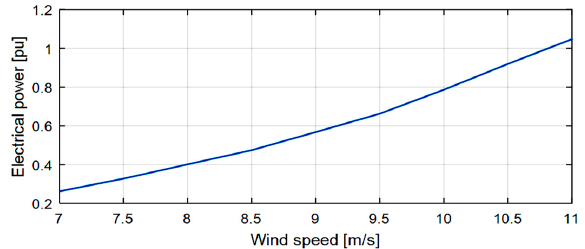
Figure 14. Contributed power of wind turbine vs. wind speed for only inertia emulation control case.